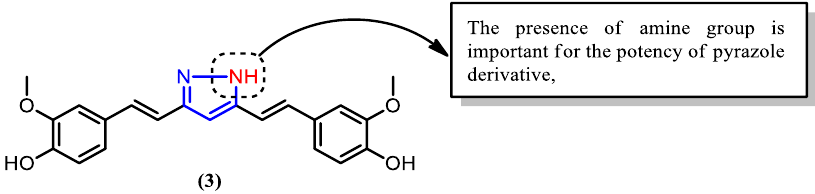
Figure 11. The pyrazole derivative of curcumin has higher efficacy than the isoxazole derivative.